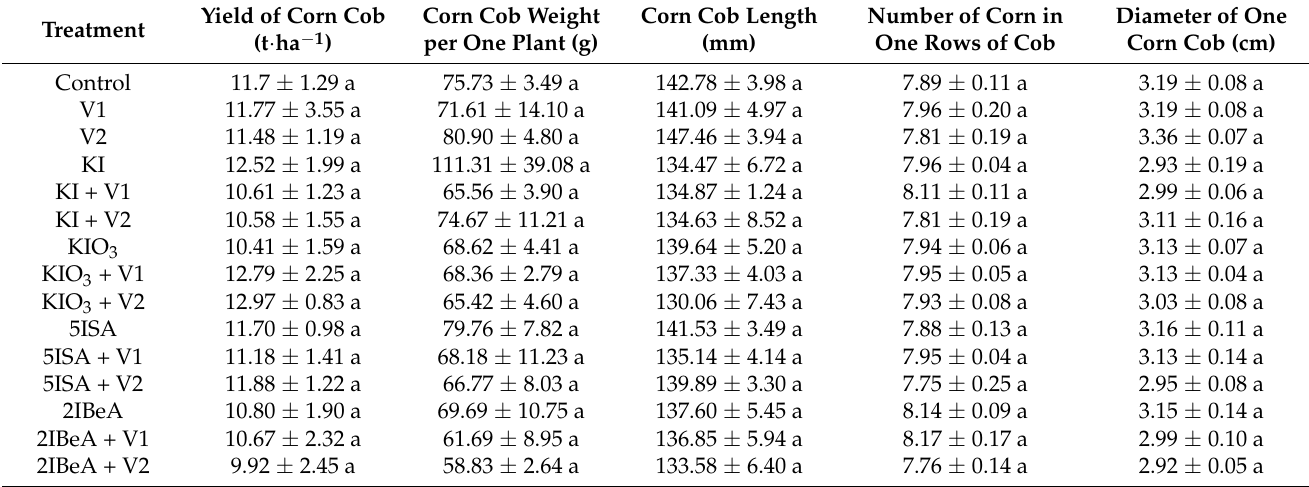
Table 2. Results of yield of corn cob, corn cob weight per one plant, corn cob length, number of corn kernels in one row of cob and diameter of one corn cob in experiment No. 2.